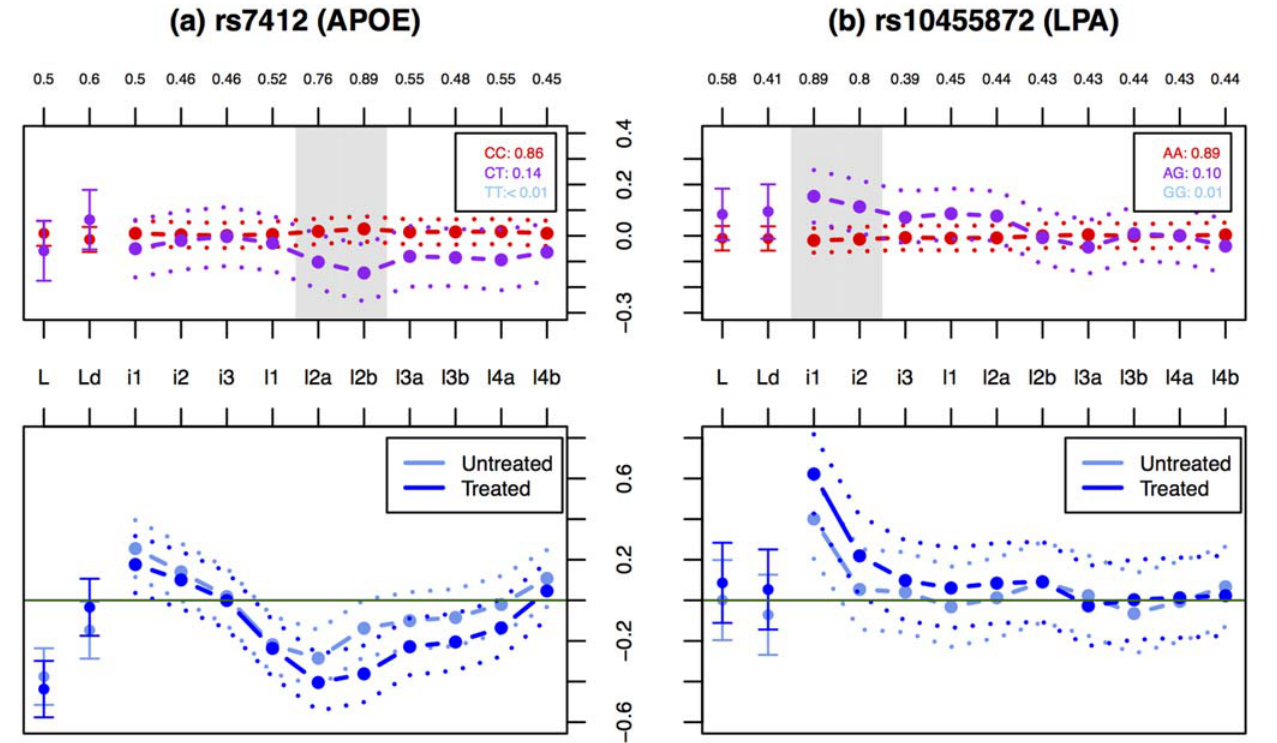
Fig 4. Effects of associated SNPs (rs7412 in APOE and rs10455872 in LPA) on treated and untreated measures of LDL subfractions, and on their difference. Upper panels show the effects of the SNPs on the difference between treated and untreated measures of LDL subfractions. Labels and colors are as in Fig 2. Lower panels show estimated effect size (dashed lines) and ± 2 standard errors (dotted lines) in the treated and untreated (normalized) phenotype for each subfraction.